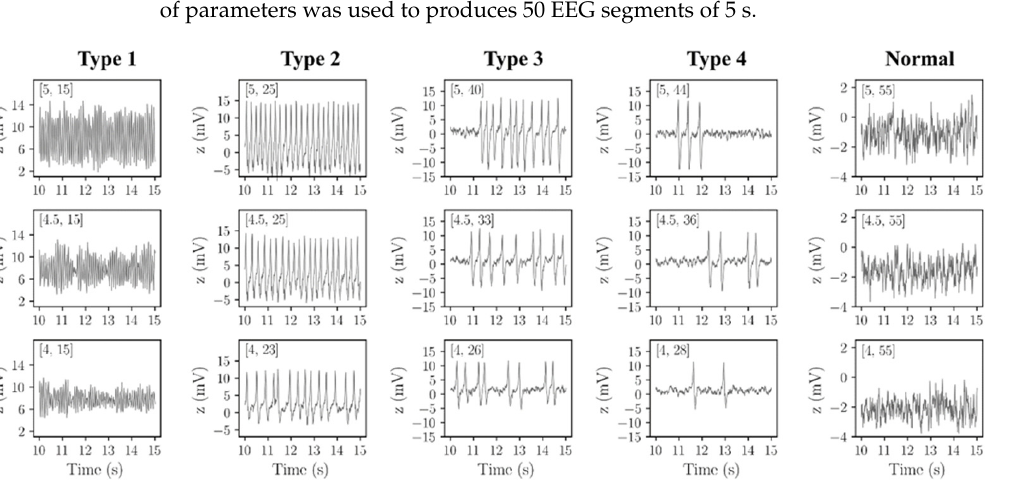
Table A1. Parameters for the mathematical seizure model of hippocampus in mice. Parameters